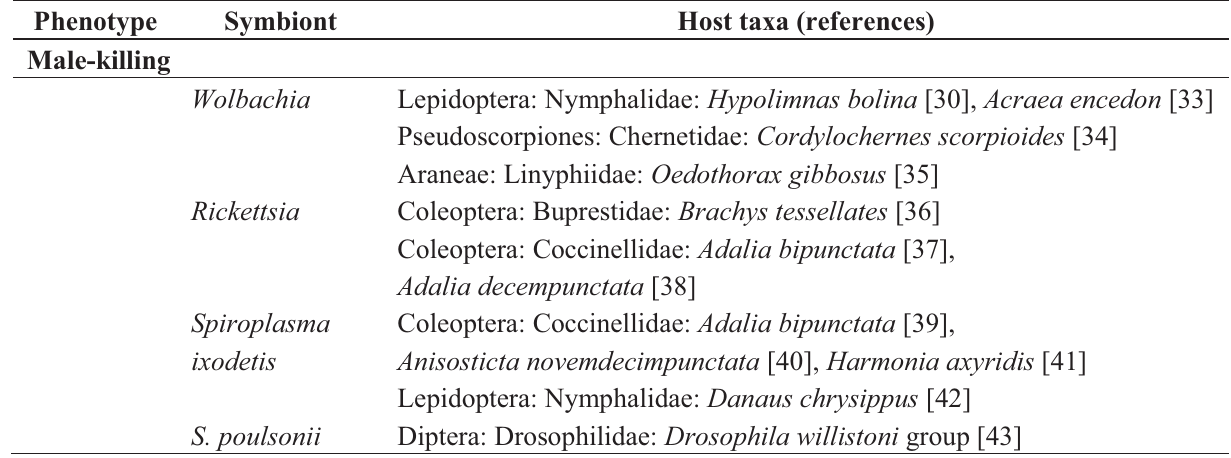
Table 1. Overview of the classic symbiont-induced phenotypes with responsible microbes and examples of known insect and arachnid host taxa in which they